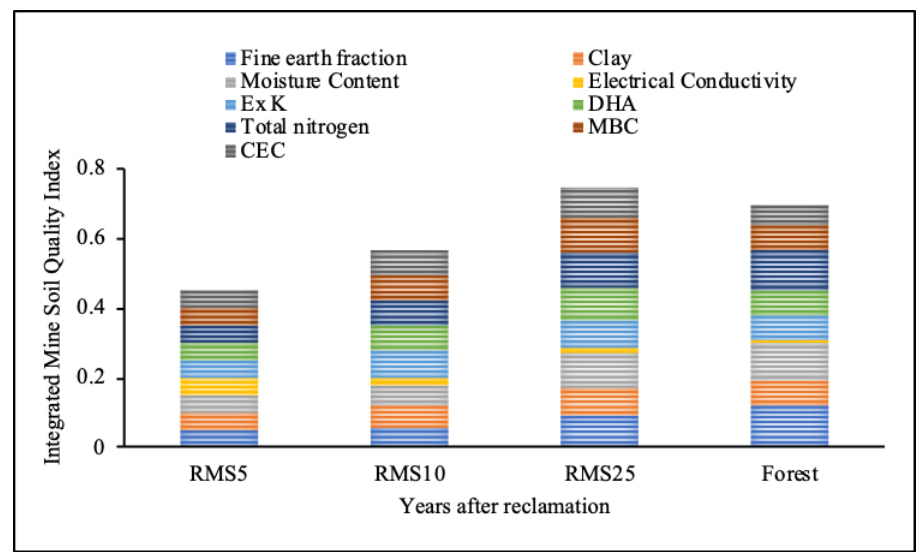
Figure 5. Contribution of each soil indicator parameter on calculated IMSQI with age of reclamation. Table 9. Pearson correlation coe ffi cients between the highly loaded variables from the principal component analysis.